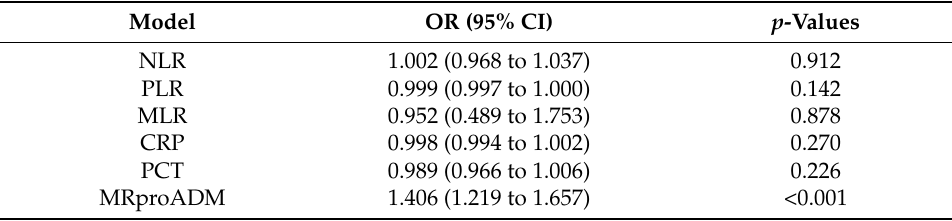
Table 6. Multivariate logistic regression model for 90-day